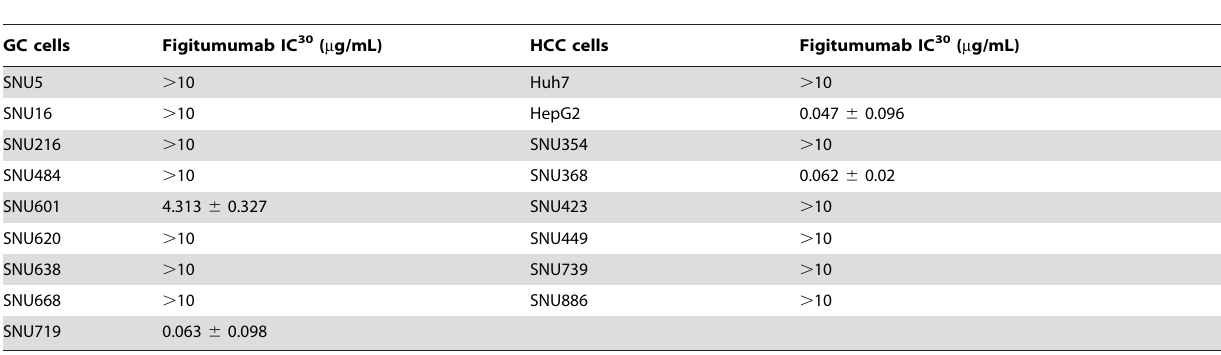
Table 1. Anti-proliferative effect of figitumumab in gastric cancer and hepatocellular carcinoma cells.